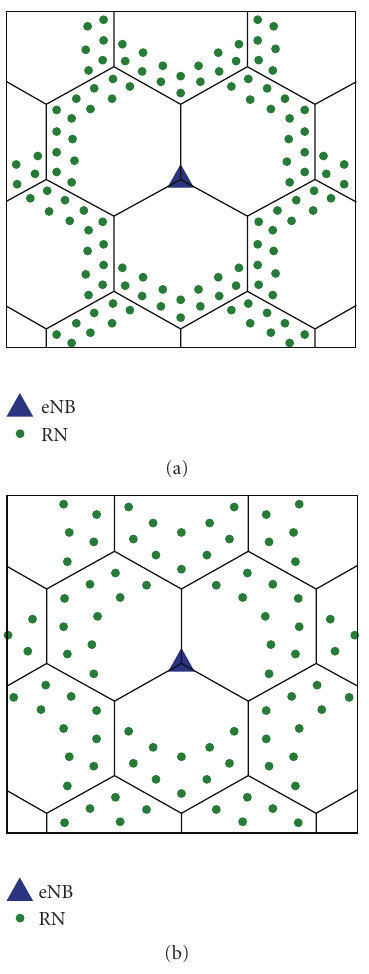
Figure 2: RN deployment in Scenario 1 (a) and Scenarios 2 and 3